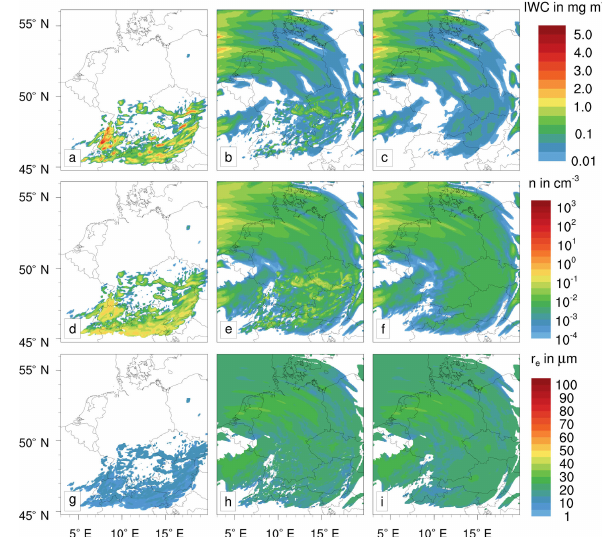
Figure 9. Analogous to Fig. 3, now for 20:00UTC.